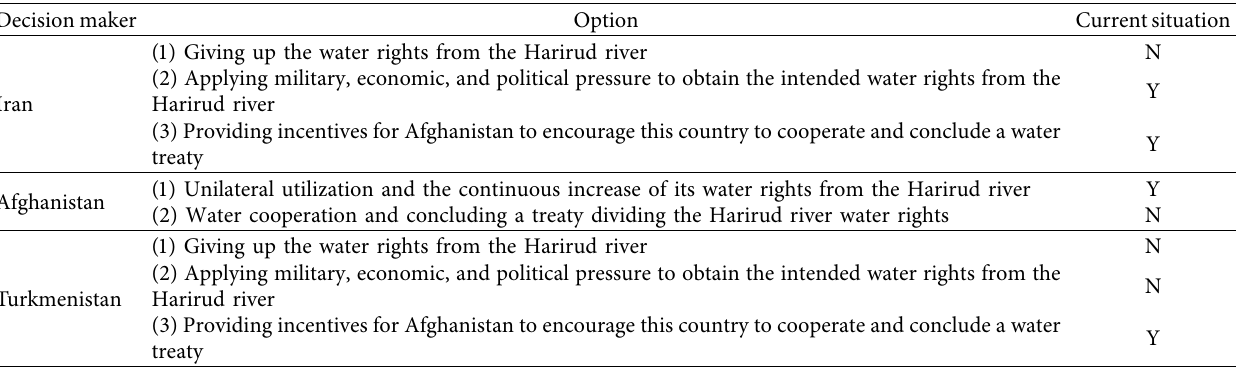
Table 2: DMs and options in the Harirud river